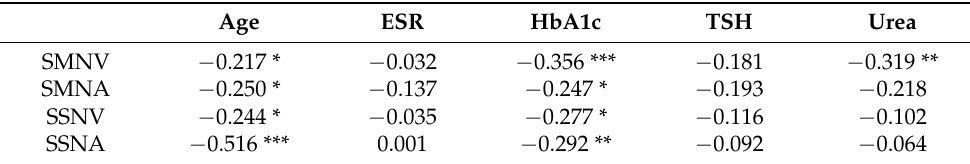
Table 4. Multiple regression models with nerve conduction parameters serving as the dependent variable—Standardized beta coefficients.